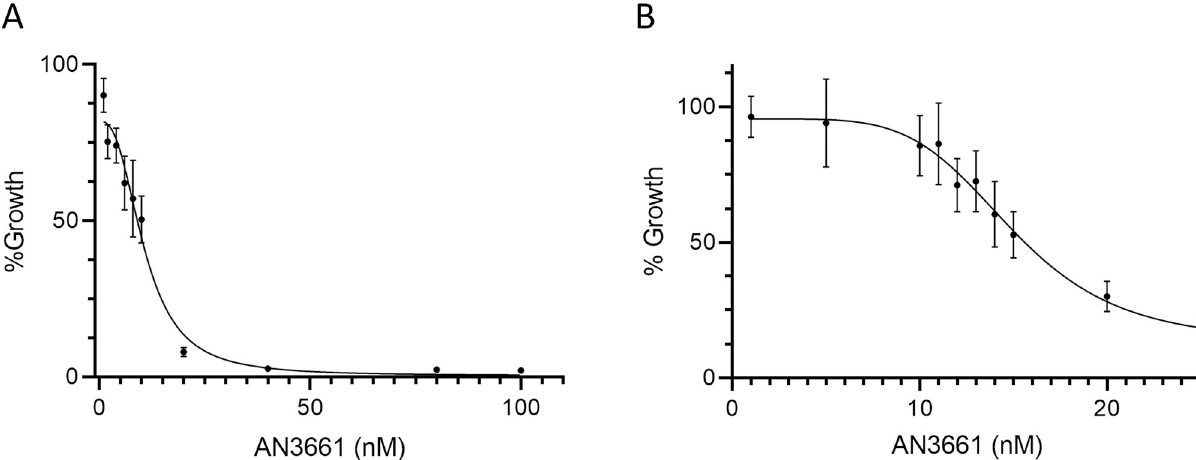
Fig 1. Growth inhibition of S . neurona by AN3661. An S . neurona clone expressing YFP was seeded into 96-well plates containing monolayers of BT host cells and incubated for 4 days ( S . neurona ) in the presence of increasing concentrations of AN3661 (eight replicates/concentration). Parasite growth inhibition was based on relative fluorescence of treated wells compared to control wells containing no drug, and the IC 50 was determined by regression analysis. (A) Parasite growth in AN3661 concentrations between 1 nM and 100 nM suggested an IC 50 of 10.68 nM, with parasite growth virtually halted at concentrations greater than 50 nM. (B) Parasite growth across a narrow range of AN3661 concentrations indicated an IC 50 of 14.99 nM.